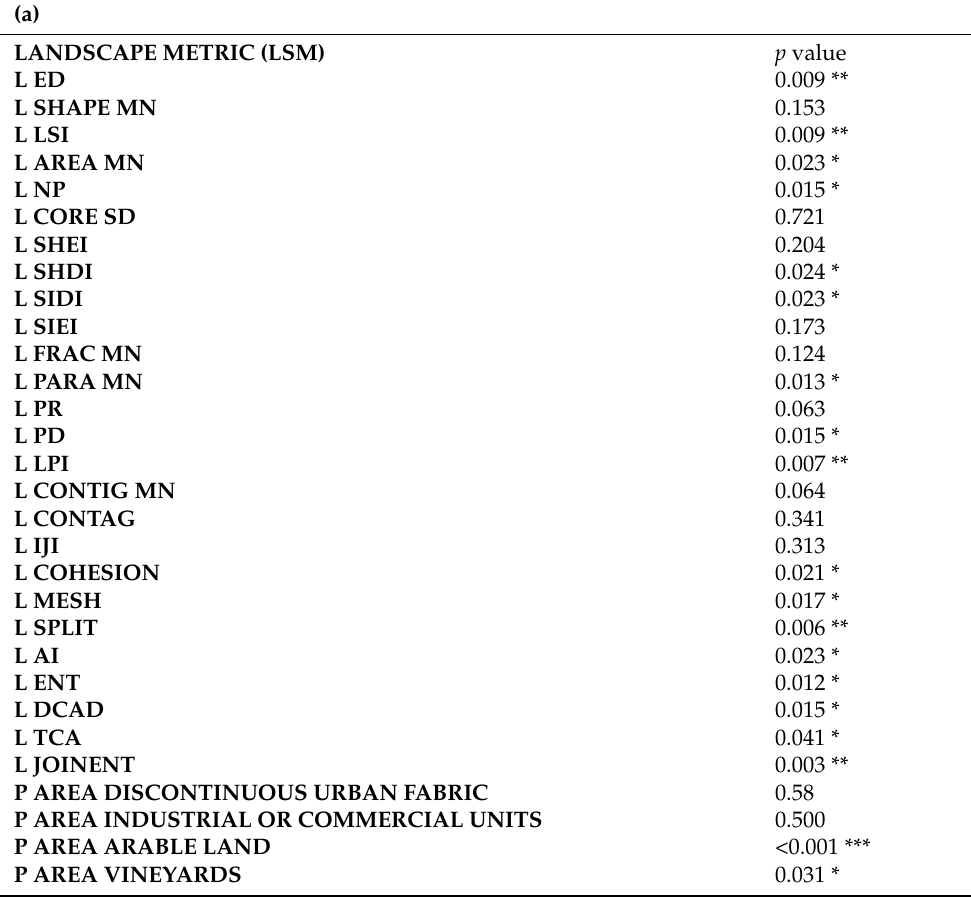
Table 2. (a–d) All initially included and tested environmental variables (landscape metrics, dig- ital elevation model, and meteorological variables). P values are displayed. For further details regarding the environmental variables and a description for an analysis using R, we refer to https://r-spatialecology.github.io/landscapemetrics/, accessed on 1 April